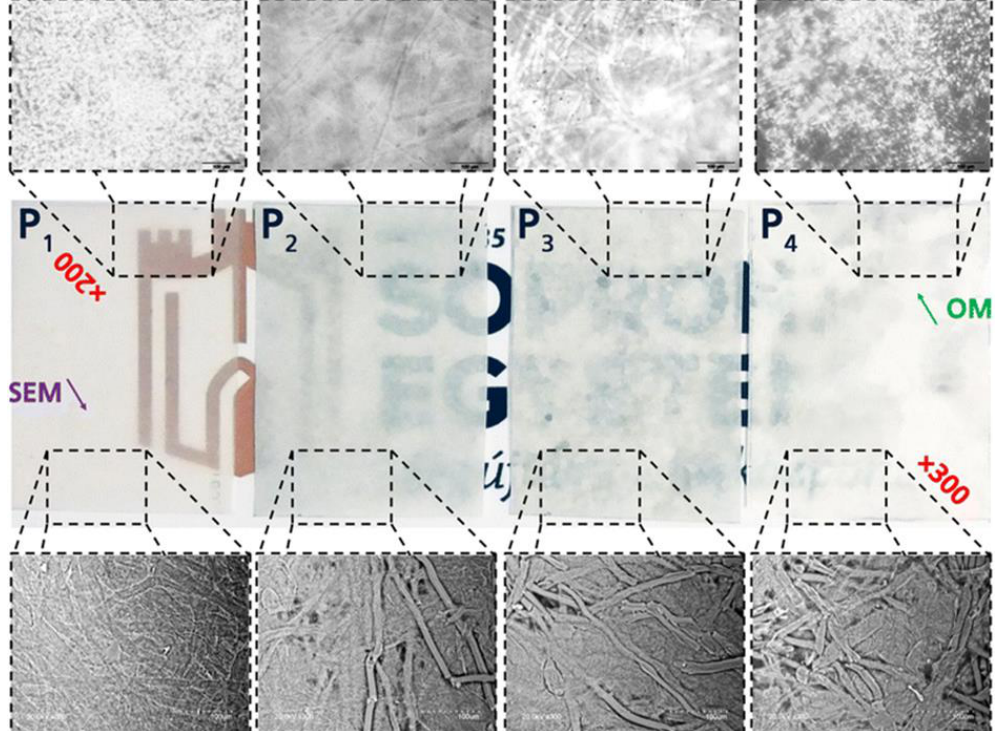
Figure 3. The first row presents optical microscopic images; the second row shows visual appearance; and the third row presents SEM images of film composites — P1, P2, P3 and P4 (Reprinted from [75]; Copyright © 2018, Springer Nature).